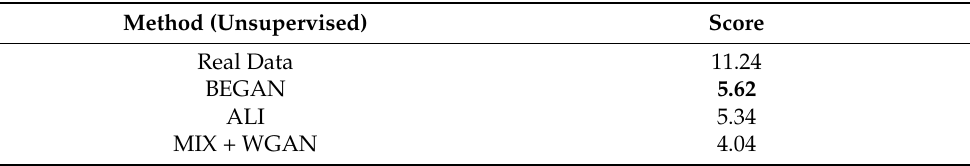
Table 8. The inception scores of various GANs, compared to real